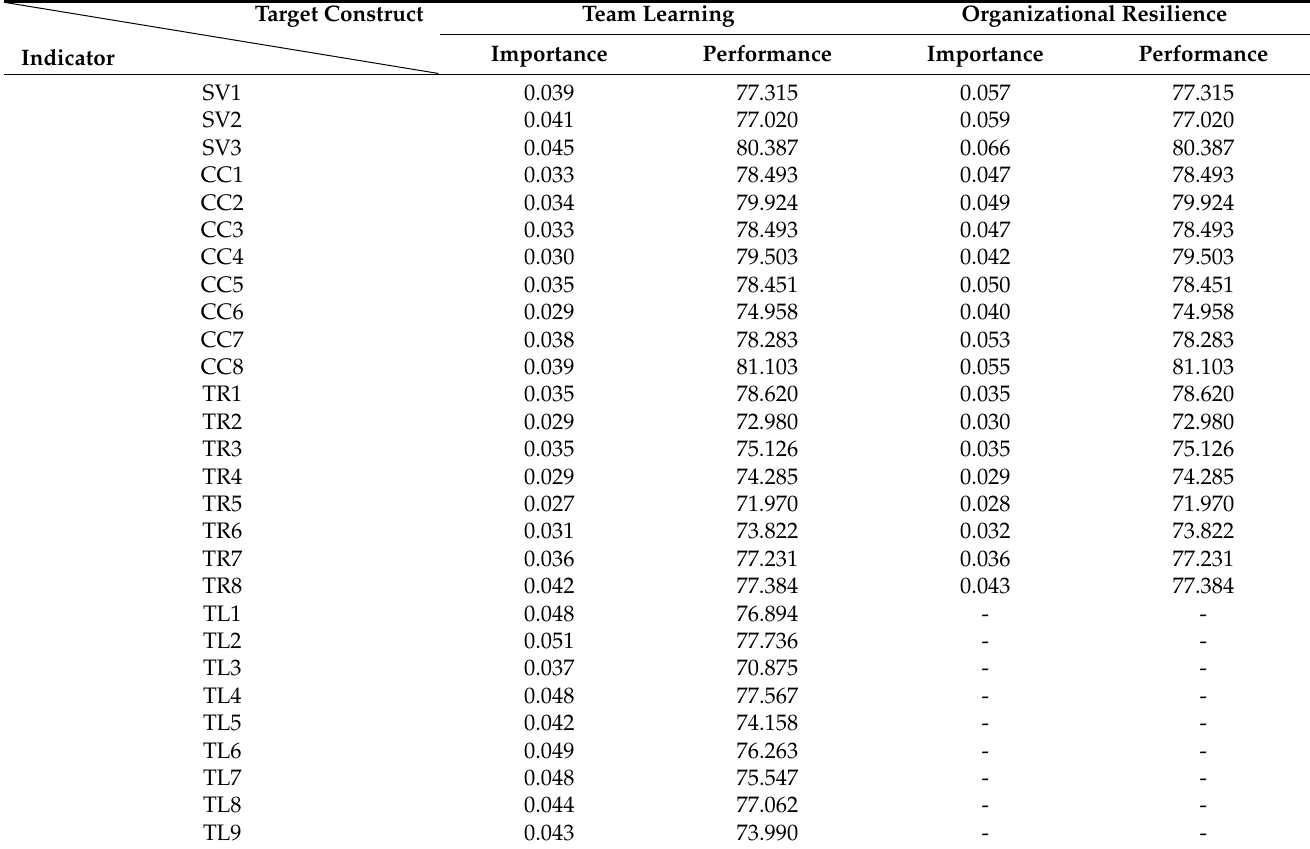
Table A2. Importance and Performance of each